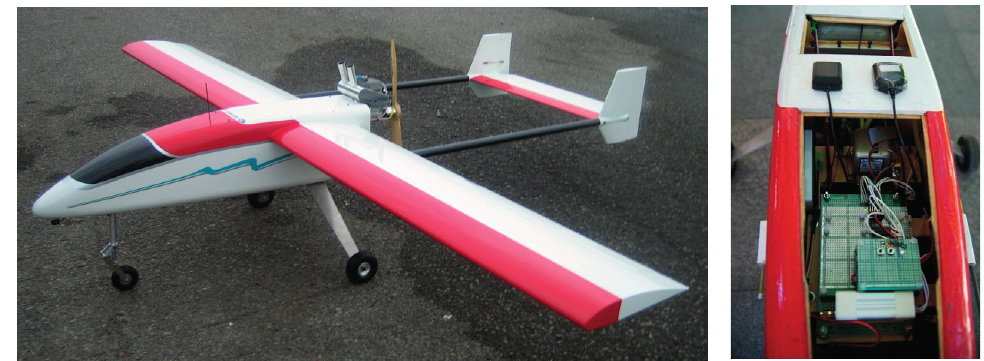
Figure 10. The UAV platform and